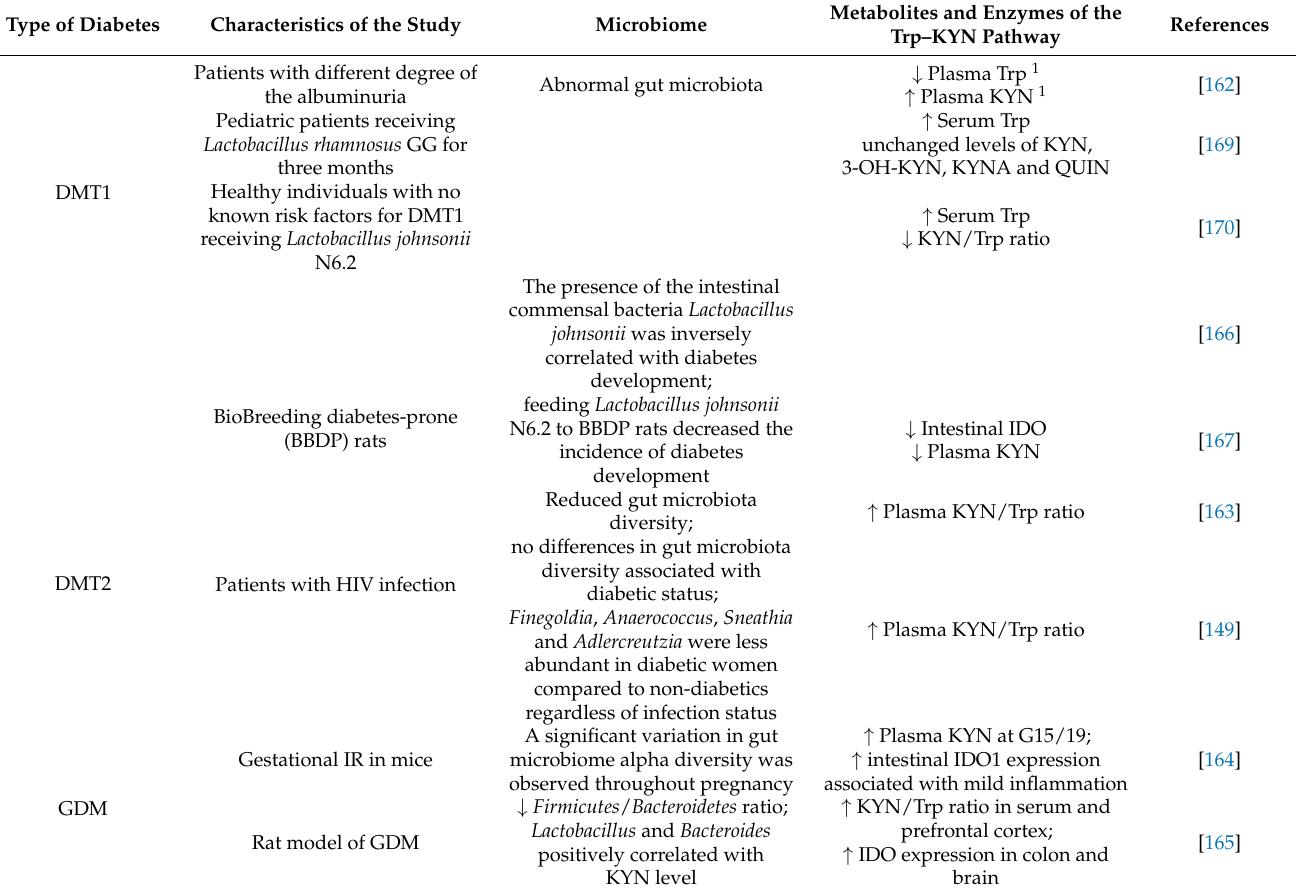
Table 4. Microbiome research in the context of diabetes mellitus and the